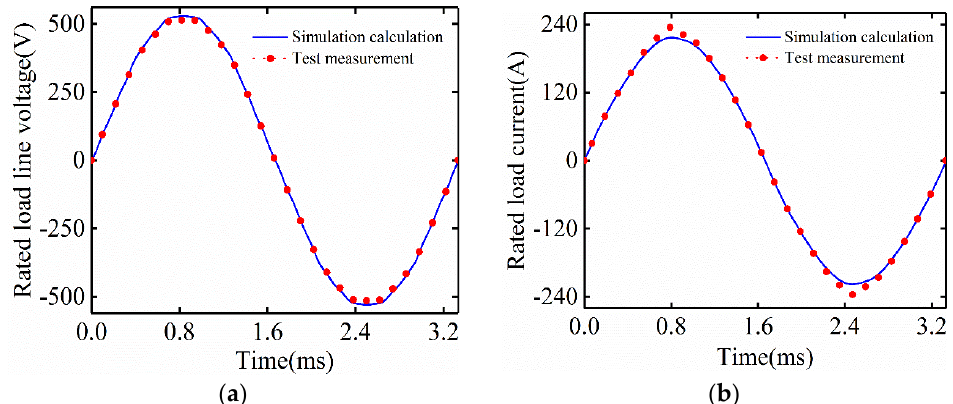
Figure 21. Simulation calculation and measured results under rated load operation, ( a ) Line voltage,